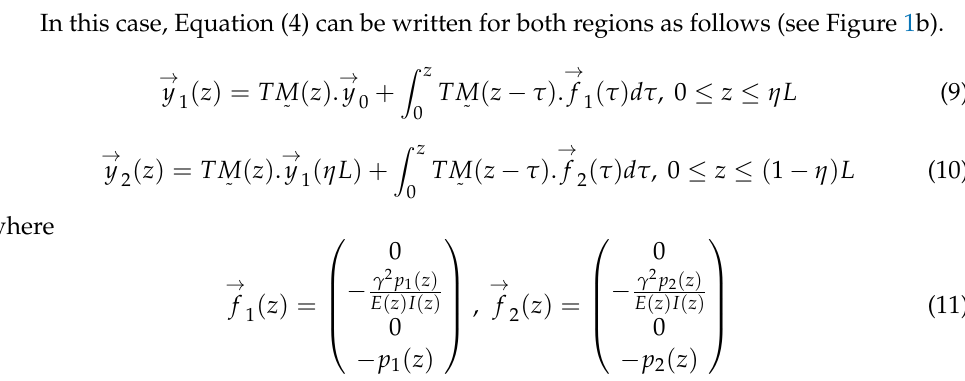
Figure 1. ( a ) A beam subjected to a distributed load; ( b ) a beam subjected to two di ff erent loads. 3.2. Beam Subjected to Two Di ff erent Distributed